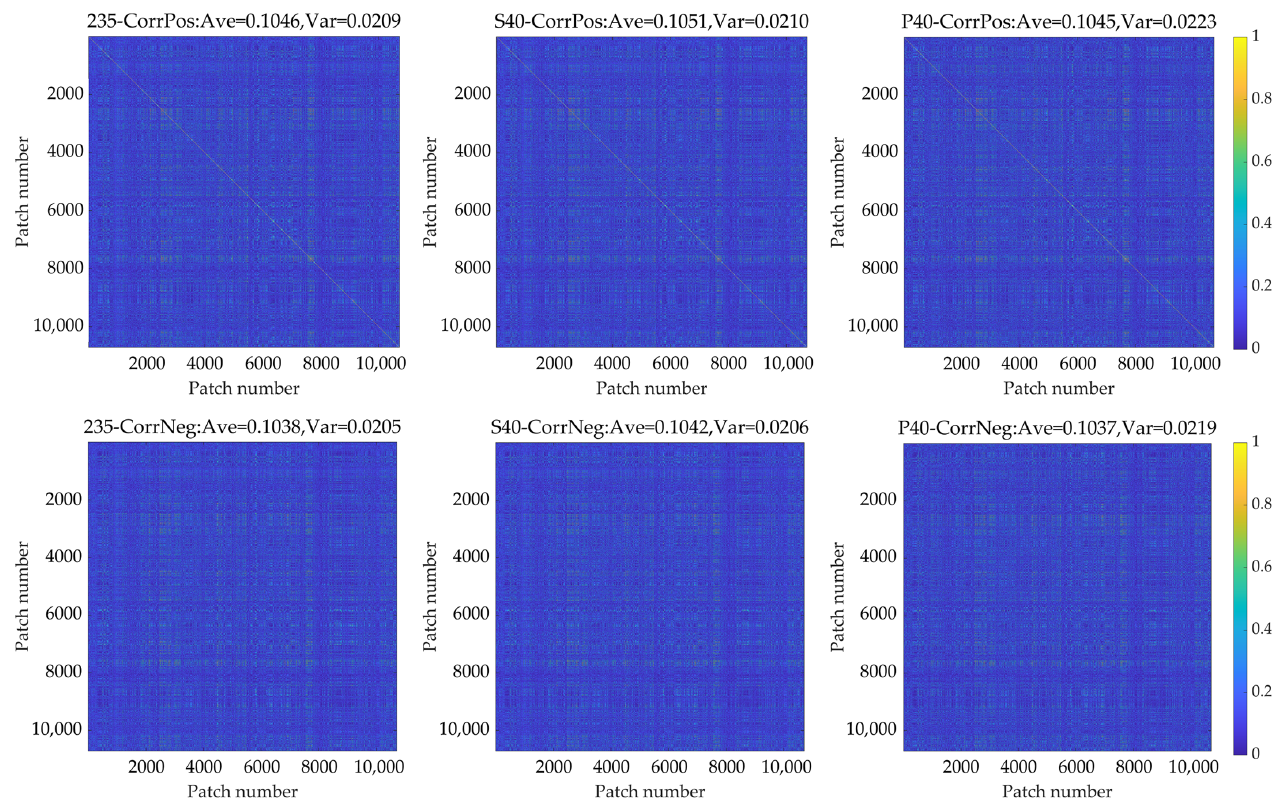
Figure 9. The correlation coefficients between patches of dataset 235, S40, and P40 were calculated according to Equations (2) and (3).